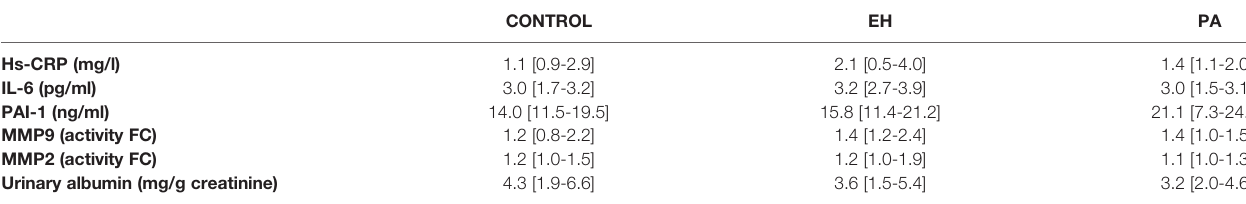
TABLE 2 | Evaluation of parameters associated with in fl ammation, endothelial and renal damage in PA subjects, EH, and controls. CONTROL